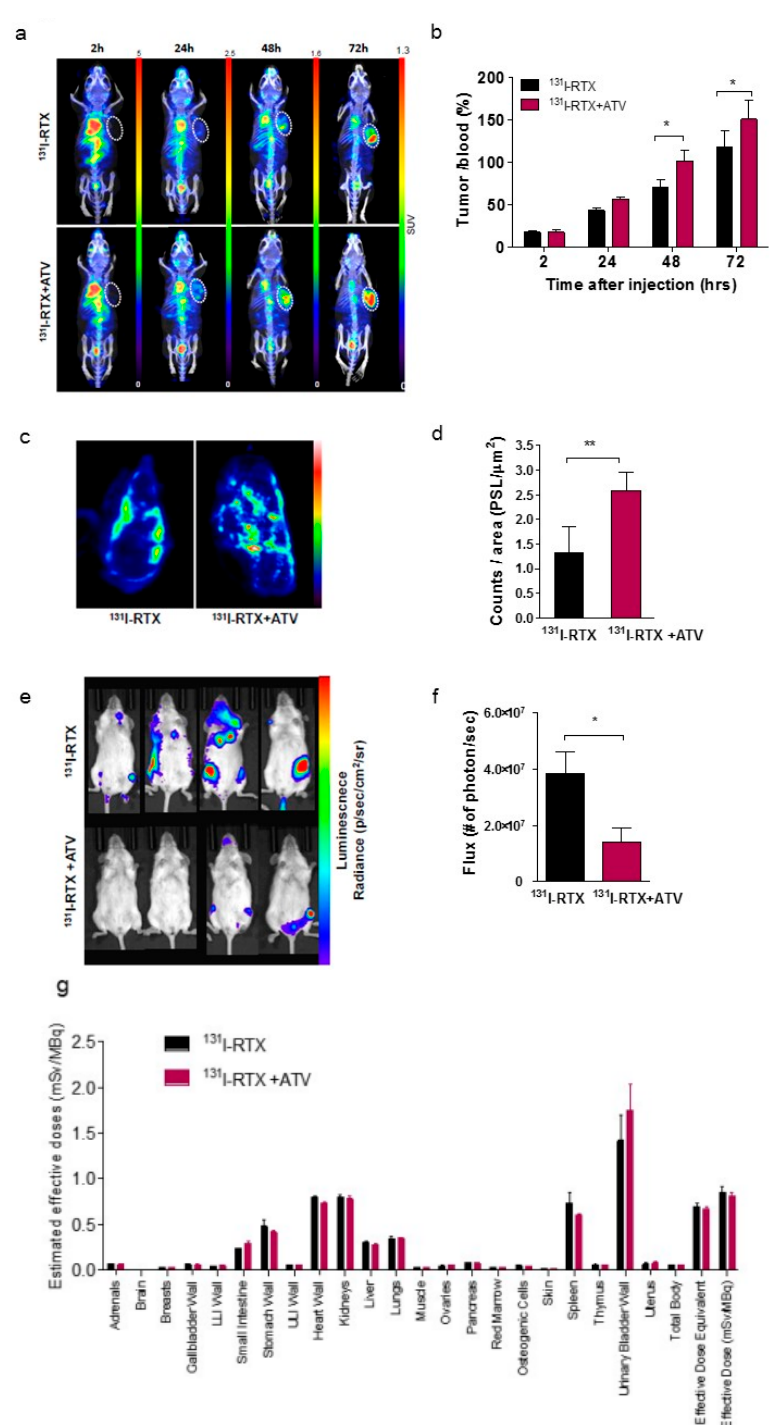
Figure 2. In vivo images of 131 I-RTX after ATV treatment in Raji lymphoma tumor tissue ( a ) Representative SPECT / CT images of Raji-xenografted mice were acquired at 2, 24, 48, and 72 h after injection of 131 I-RTX (upper row) and ATV plus 131 I-RTX (lower row). White dotted circles indicate the tumor region. ( b ) The quantification of 131 I-RTX accumulation in tumors is represented by the tumor to blood ratio at each time point (* p < 0.05). The data are the mean ± SD from five independent mice.